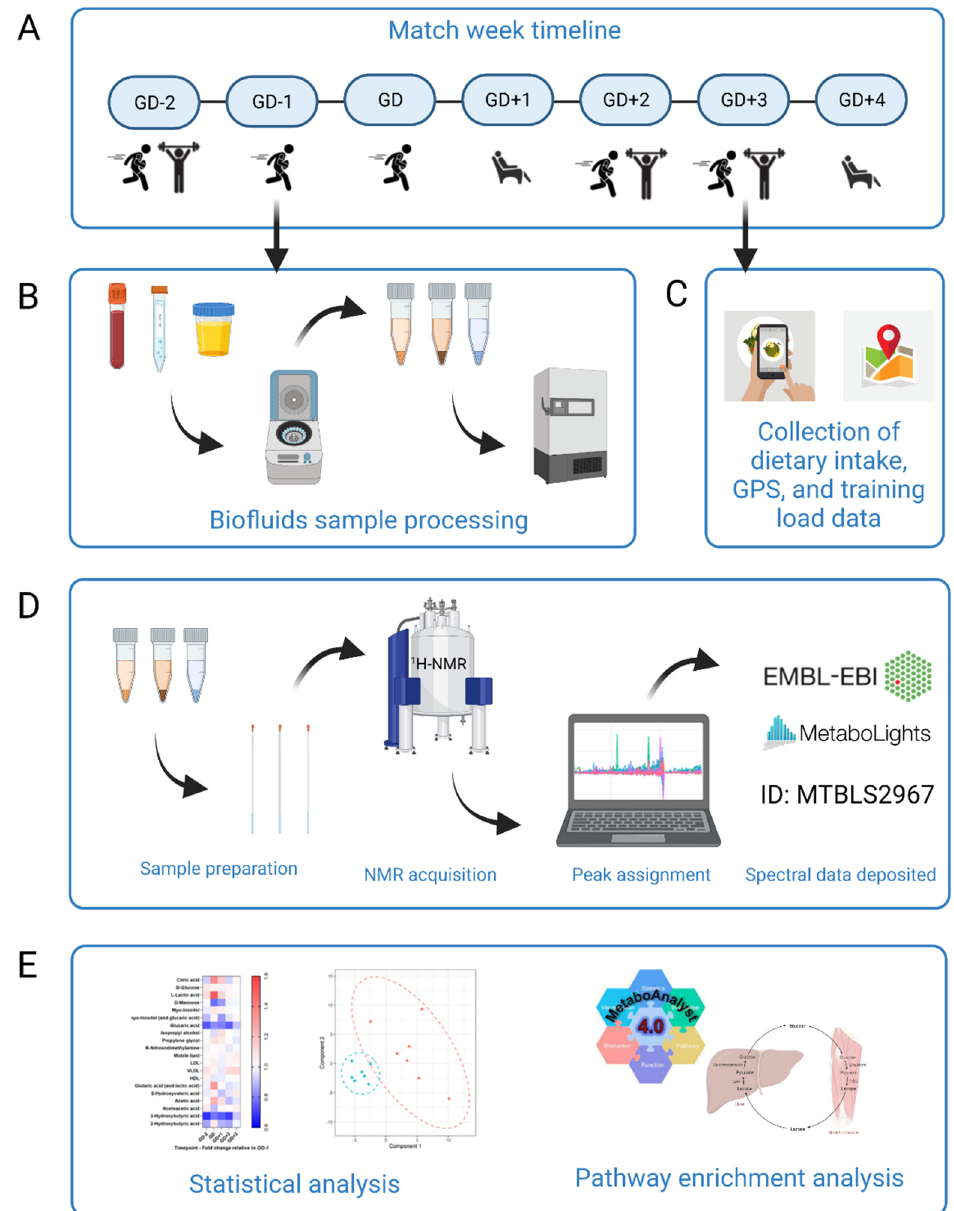
Figure 1. Schematic overview of the study design. ( A ) Participants ( n = 7) began the study at GD-2 and completed a whole match week schedule of rugby specific sessions, resistance training and rest. ( B ) Biofluids sample processing. Participants provided samples of blood, urine, and saliva every morning apart from the GD sample which was taken immediately post-match play. Samples were processed immediately with timings rigorously repeated each day. Biofluids were then frozen for later analysis. ( C ) Dietary intake for all seven days using the Snap’n’Send method, with all GPS and load data were collated. This was all analyzed to further translate changes to the metabolome. ( D ) Sample preparation and analysis by 1 H-NMR. Spectra were acquired and then peaks assigned using Chenomx. Full spectrum parameter sets are available with the data deposited at MetaboLights public repository (ID number MTBLS2967). ( E ) Statistical analysis. Univariate and multivariate data analysis was performed in R to elucidate key metabolites between all sample timepoints. MetaboAnalyst 4.0 pathway enrichment analysis was then carried out with those statistically significant and key discriminatory metabolites. Figure created using